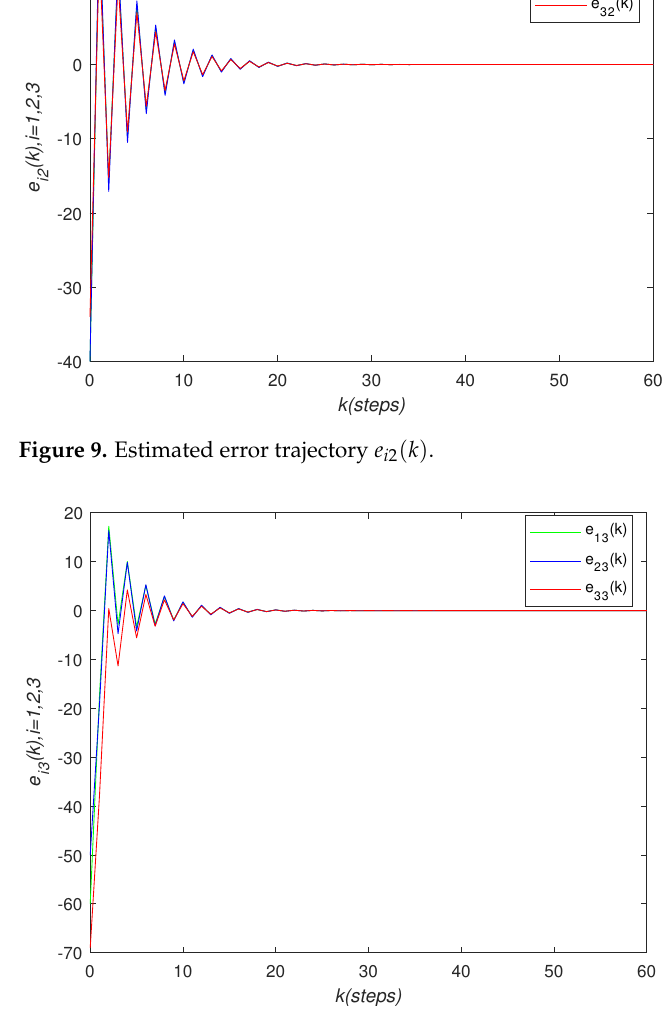
Figure 10. Estimated error trajectory e i 3 ( k )